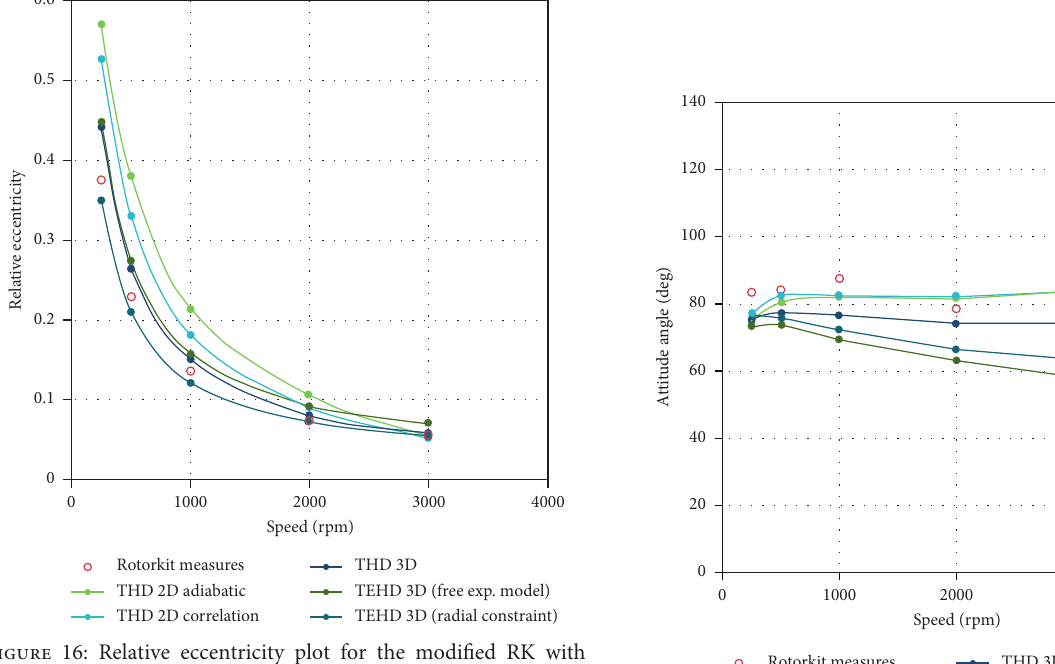
Figure 17: Relative eccentricity plot for the modified RK with respect to 3D numerical THD and TEHD simulation results in configuration 2.